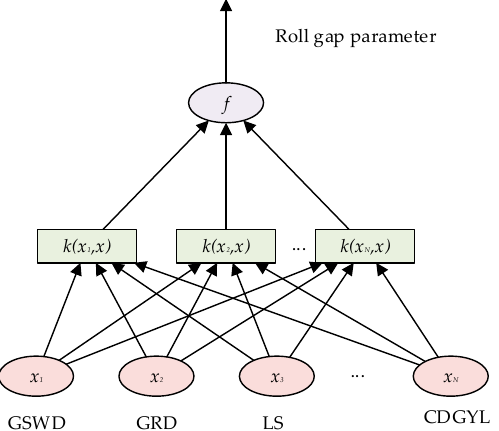
Figure 4. Roll gap value prediction model of streaming data from multi-source information. f is the output of the model.